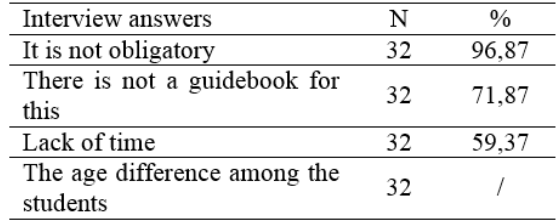
Table 2. Interviewed teachers comment about recording the individual differences in a separate summative